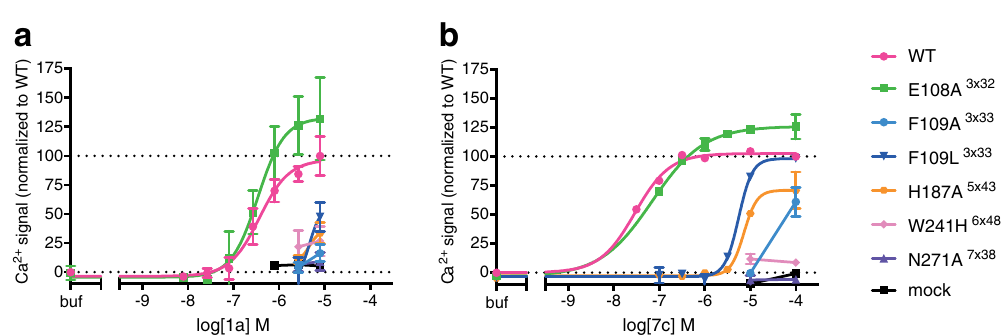
Figure 3. Effects of GPR139 mutations on pharmacological profiles of 1a and 7c. The data demonstrates that the residues F109 3 × 33 , H187 5 × 43 , W241 6 × 48 and N271 7 × 38 are important for GPR139 activation by 1a and 7c , whereas residue E108 3 × 32 is not. Concentration-response curves of ( a ) 1a and ( b ) 7c , on the mutants with an effect (plus WT, mock and E108A 3 × 32 ). The graphs are one representative (mean ± S.D.) out of three independent experiments performed in ( a ) triplicates and ( b ) duplicates. All responses are normalized to myc- GPR139(WT) (0% = buffer, 100% = 8 μ M 1a or 100 μ M 7c